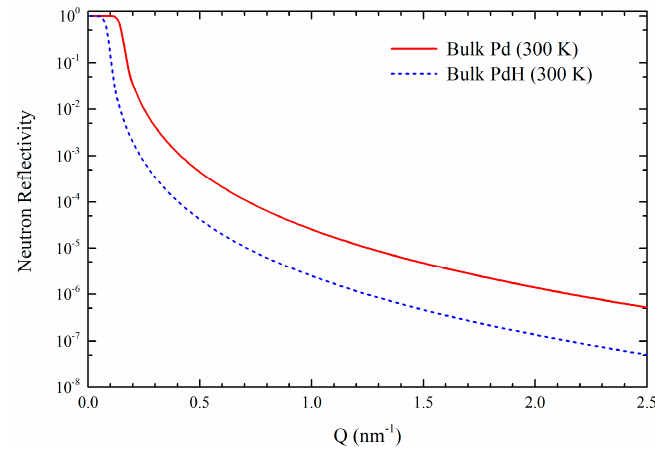
Figure 4. Simulated neutron reflectivity curves of a bulk Pd surface (red solid line) and a Pd-hydride bulk surface (blue dashed line).